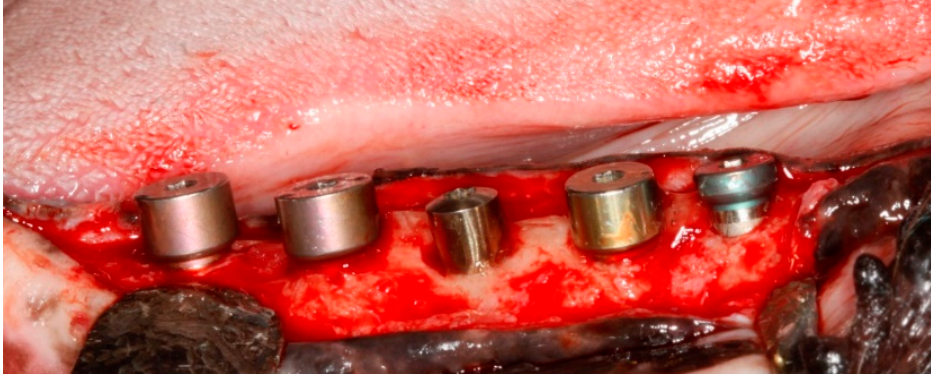
Figure 3. Intra-operative view of the implants at the exposure time, 3 months post-implantation, with the healing abutments in place.